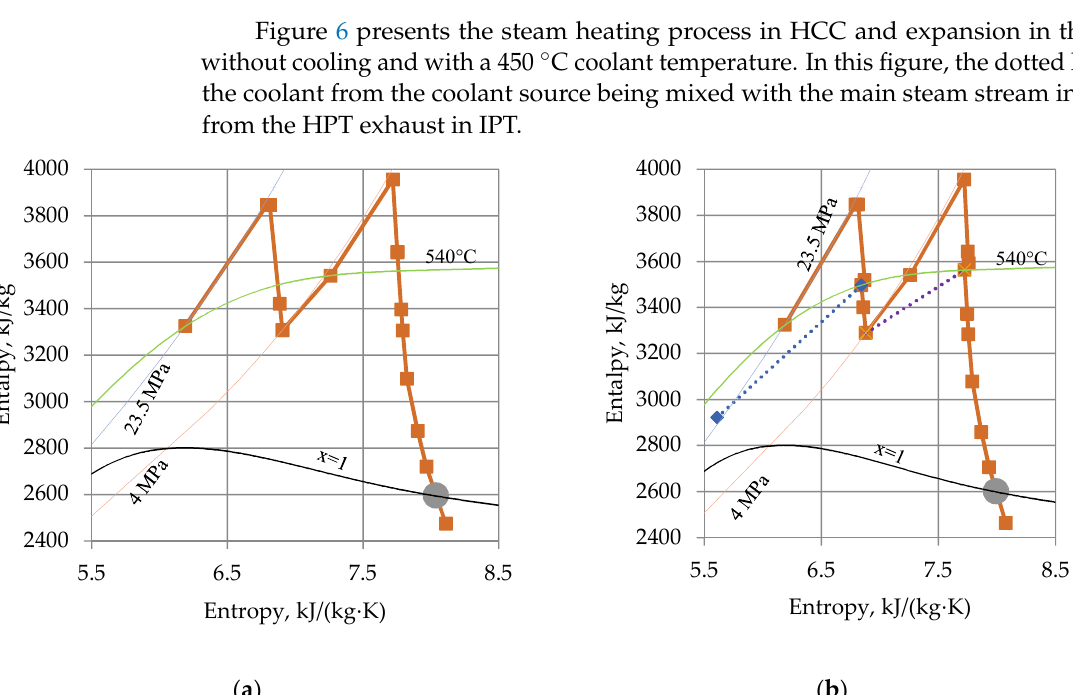
Figure 6. Steam heating in the HCC expansion in the steam turbine: ( a ) Uncooled turbine; ( b ) cooled turbine with 450 °C coolant temperature.